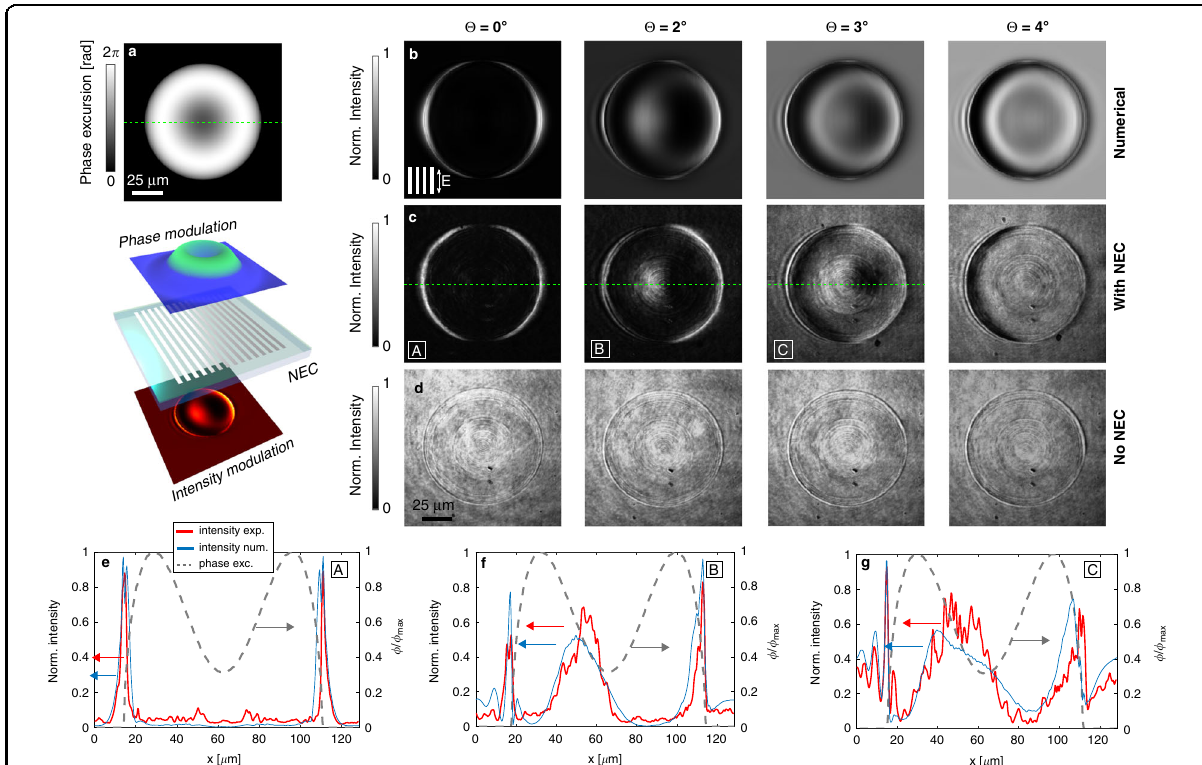
Fig. 3 Experimental phase visualisation showing the change in phase contrast with tilt angle of the NEC for incident light polarised along the grating stripes. a The phase pro fi le generated by the spatial light modulator, inspired by a magni fi ed model of a red-blood cell, and the conceptual con fi guration using the NEC. b – d Four examples of phase imaging each with the incident light tilted at a different angle Θ relative to the NEC surface normal ( b ) calculated images, ( c ) measured images with the NEC, grating orientation and incident polarisation as indicated by inset in b . d Measurements without the NEC. e – g Pro fi les of the intensity along the dashed line through three images (red) as labelled by e A, f B, and g C that show quantitatively the increased transmission associated with phase gradients. Included in the graphs are the phase pro fi le of the red-blood cell model (dashed grey) and the calculated contrast pro fi les